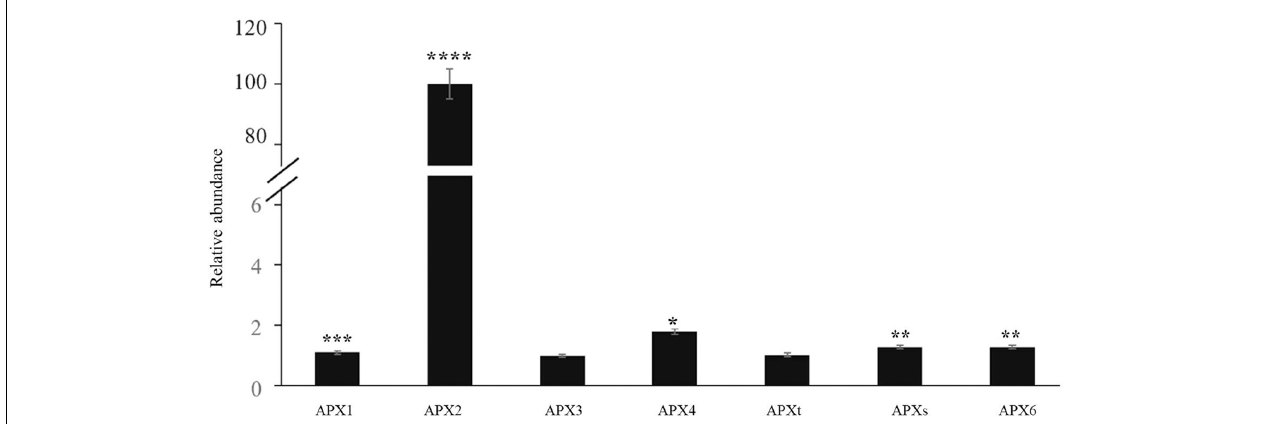
FIGURE 3 | The abundance of transcripts encoding all the Arabidopsis ascorbate peroxidase (APX) family members in control and heat-stressed seedlings. The APX gene family included three cytosolic ( APX1 , APX2 , APX6 ) forms, two chloroplast forms (a stromal form APX s and a thylakoid form APX t ), and two microsomal ( APX3 ,